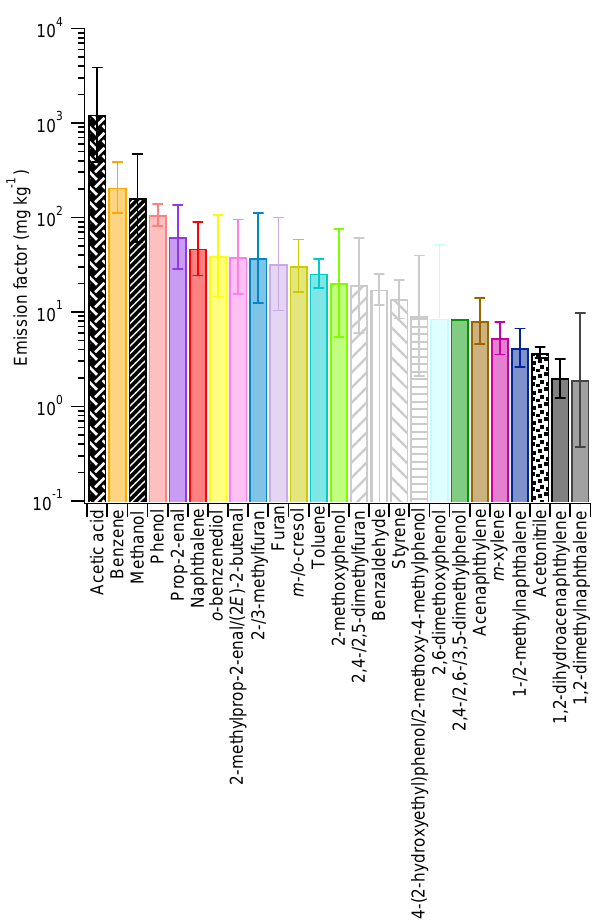
Figure 3. Geometric mean of the primary emission factors for gas- phase species of particular interest for SOA formation (solid bars and gray patterned bars) and identification of air masses influenced by biomass burning (black patterned bars). Colors and patterns cor- responding to NMOGs contributing to SOA formation are consis- tent with Bruns et al. (2016). Error bars correspond to the sample geometric standard deviation of the